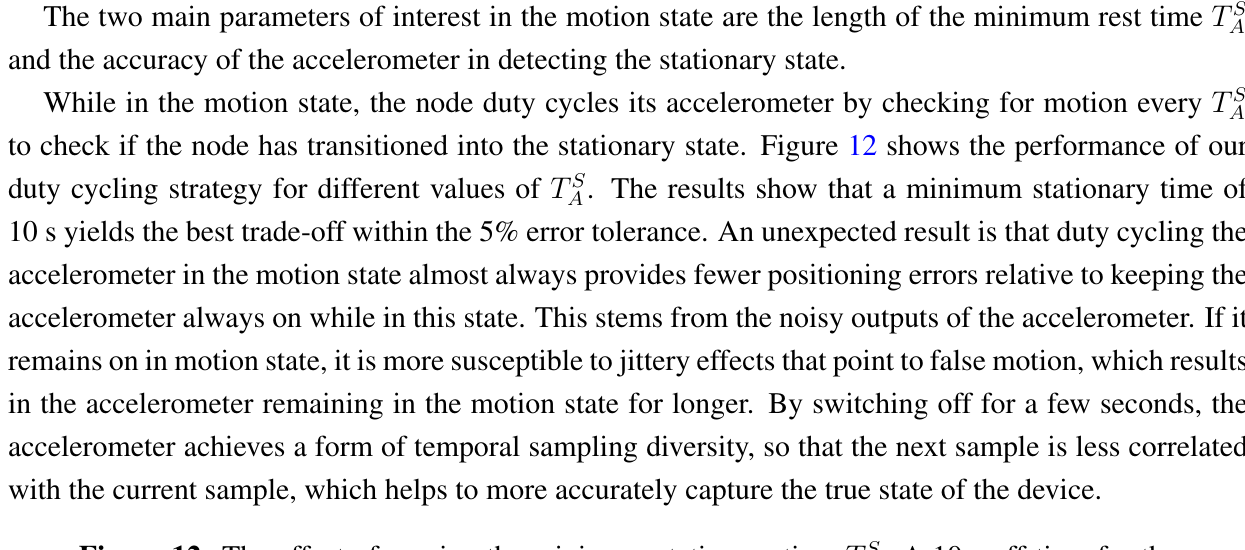
. A 10 s off-time for the A